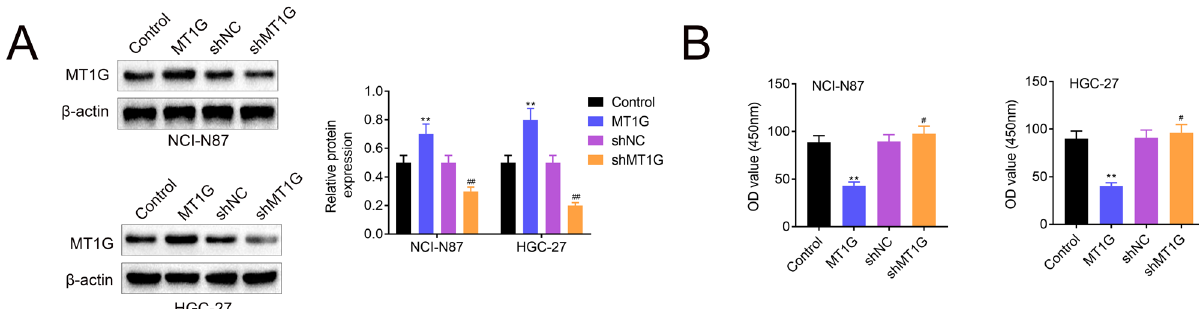
Figure 2 – MT1G facilitates gastric cells growth. (A) NCI-N87 and HGC-27 cells were transfected with indicated plasmids, and the expression of MT1G was determined by western blotting. (B) The cell proliferation in MT1G overexpression or knockdown NCI-N87 and HGC-27 cells was tested by the